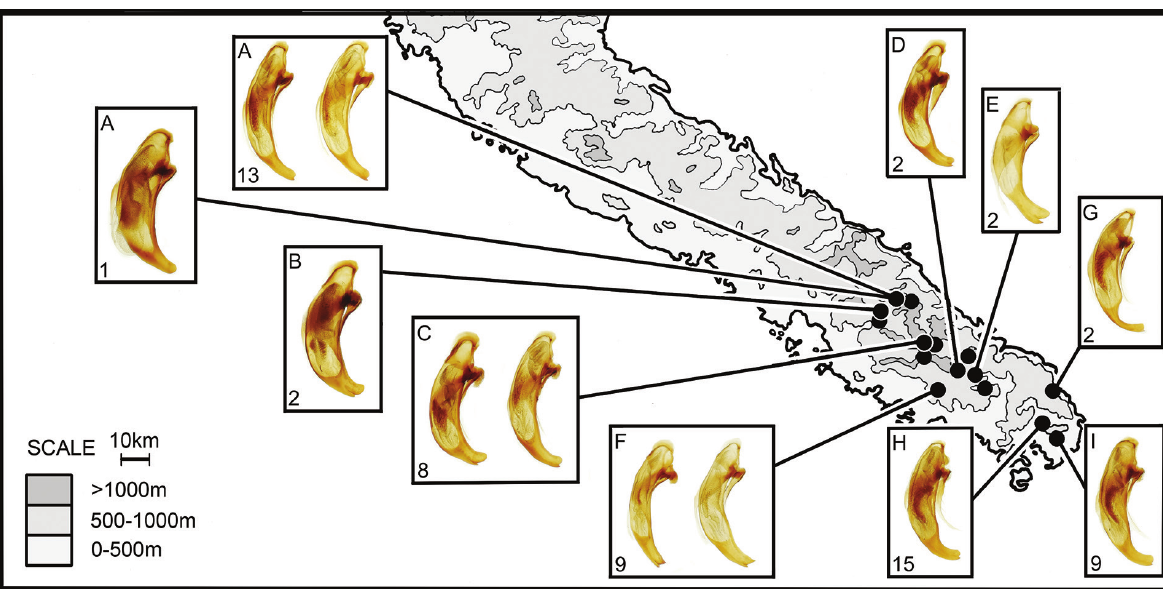
Figure 26. Recorded geographical distribution of M. kanak (including population samples A–I for which representative male aede - agi are figured): numbers of males sampled for each locality indicated in lower left of boxes. Sampled population localities include: A , Mt. Humboldt, 1300–1400 m; B , Mt. Humboldt, 600 m; C , Mt. Dzumac; D , Rivière Bleue, 800 m; E , Rivière Bleue, 400 m; F , Mts. Koghis; G , Col de Yaté; H , Pic du Grand Kaori; I , Forêt